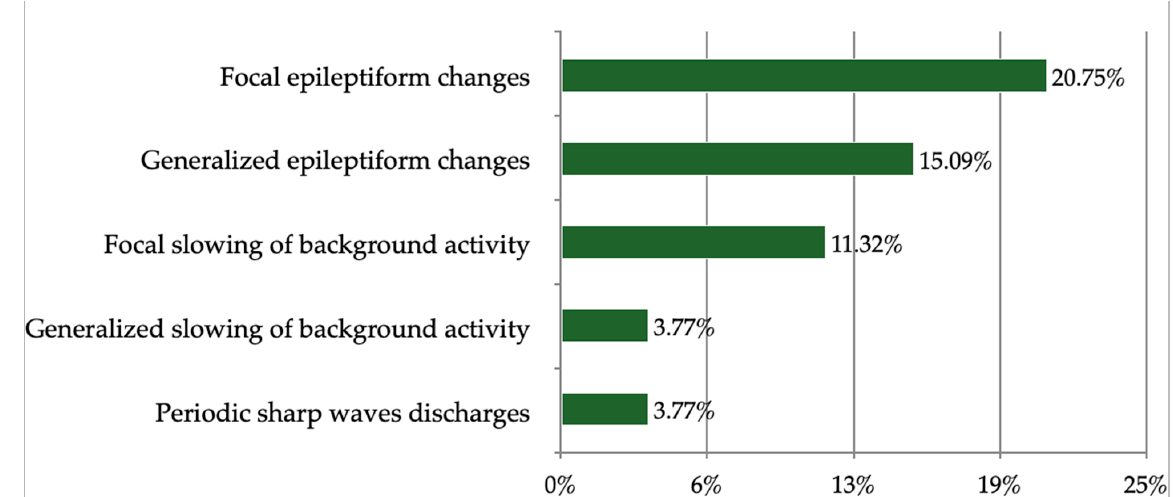
Figure 2. Abnormalities recorded in the EEG examination in the study population.